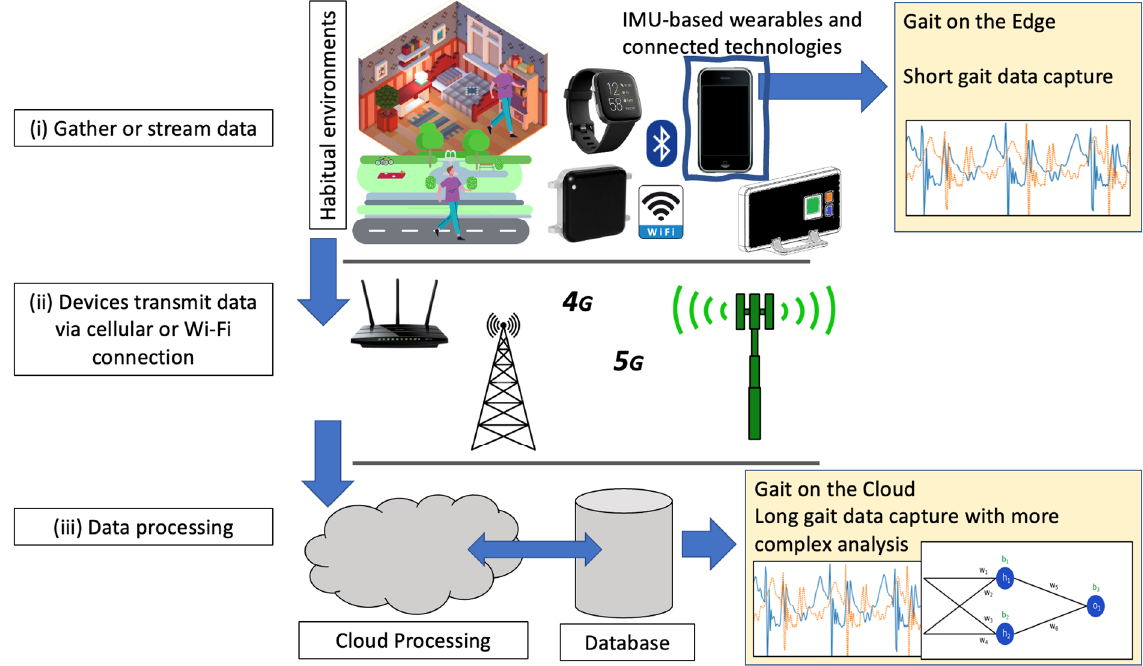
Figure 2. Considerations of remotely assessing gait within an IoT context, demonstrating (i) a collection of IoT-enabled wearable and deployable devices streaming to an edge computing instance, e.g., smartphone; (ii) data being transmitted through wireless infrastructure from edge computing devices; and (iii) receiving data within a cloud instance for processing and